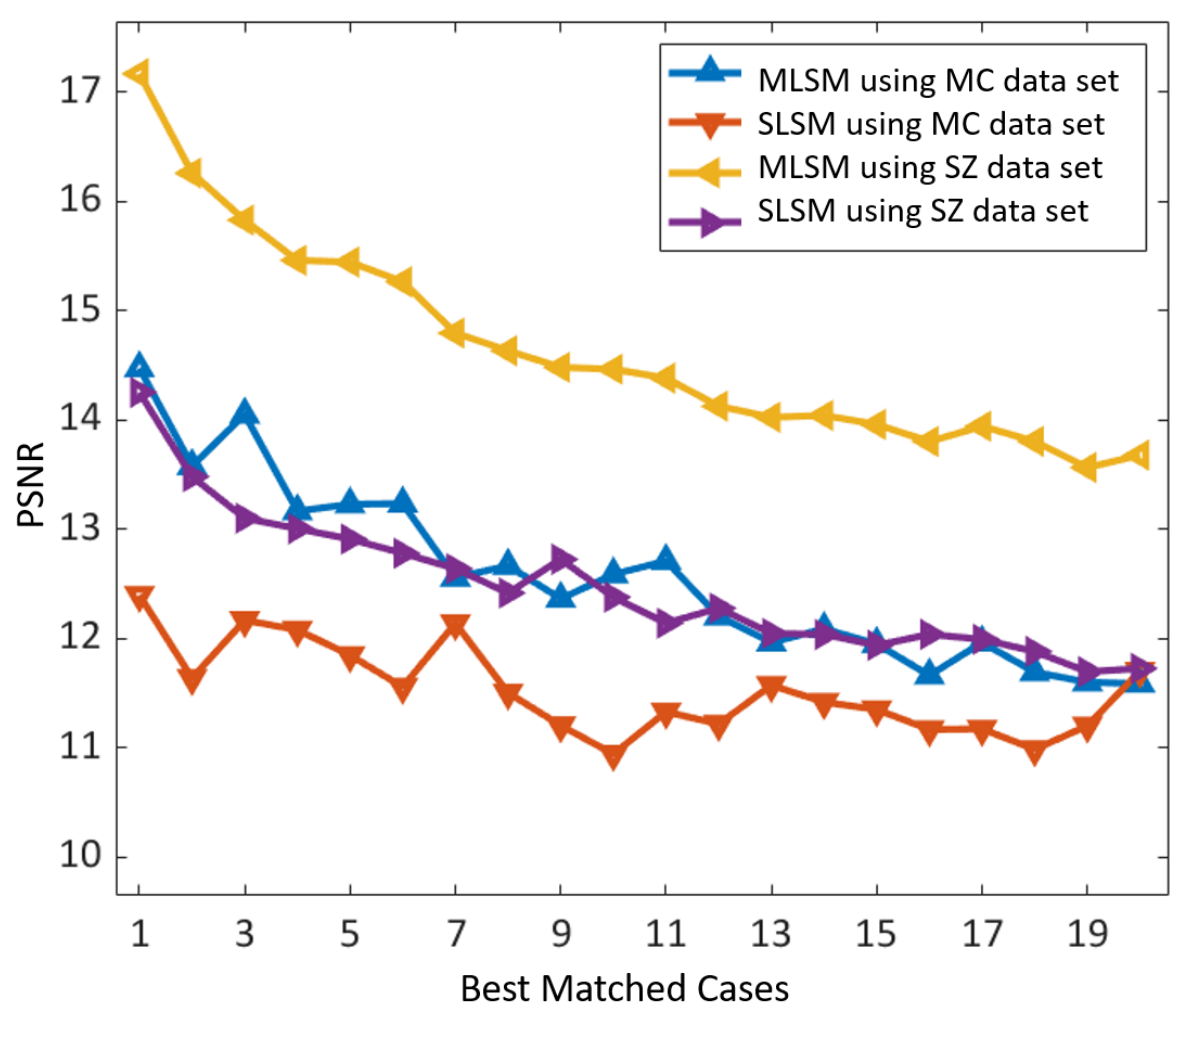
Figure 9. PSNR-based objective similarity measures between the high-level activation maps of the query image and retrieved images to evaluate feature-level similarities of both algorithms (ie, MLSM and SLSM). MLSM: multilevel similarity measure; PSNR: peak signal-to-noise ratio; SLSM: single-level similarity